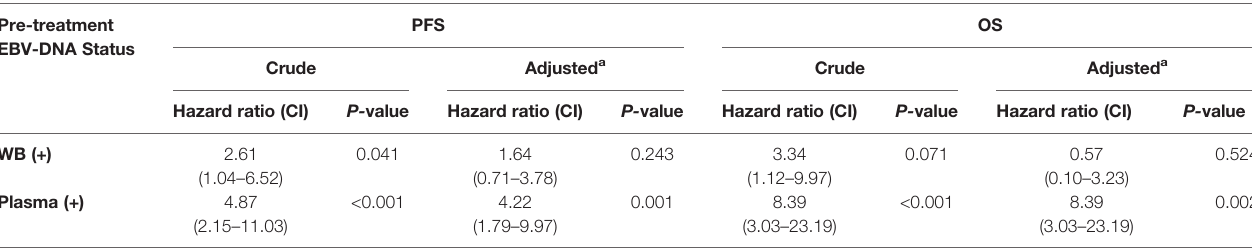
TABLE 3 | Univariable and multivariable analyses for progression-free survival and overall survival.